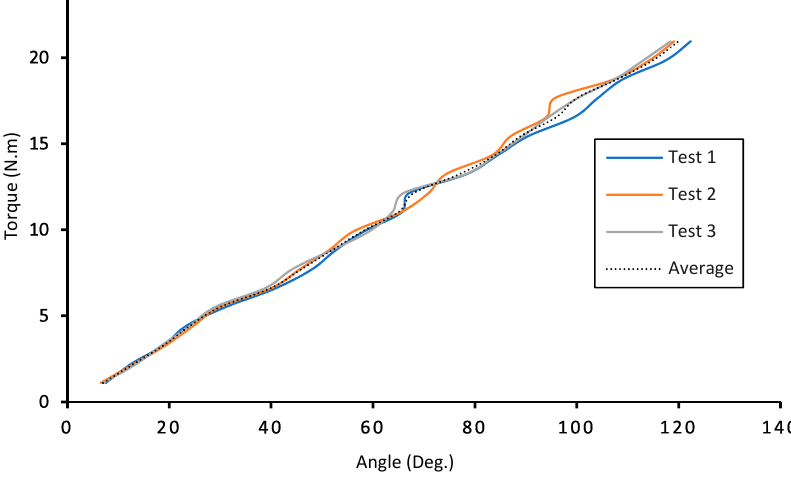
Figure 17. Characteristic of spiral spring stiffness for three tests.